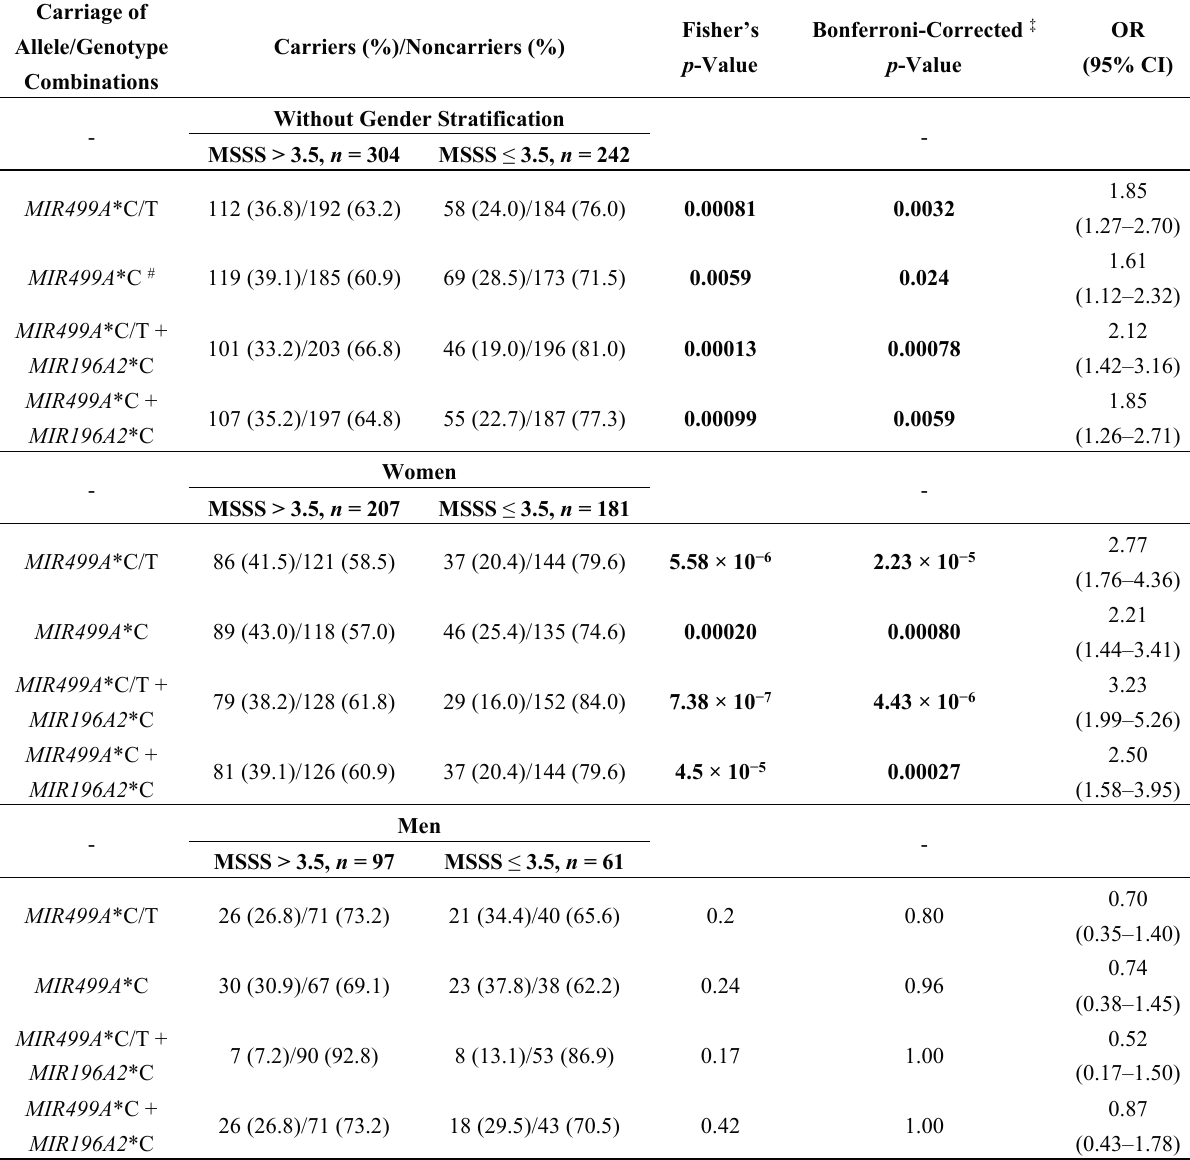
Table 3. Positive associations of SNPs in miRNA genes with the higher MS severity, evaluated by MSSS value † .